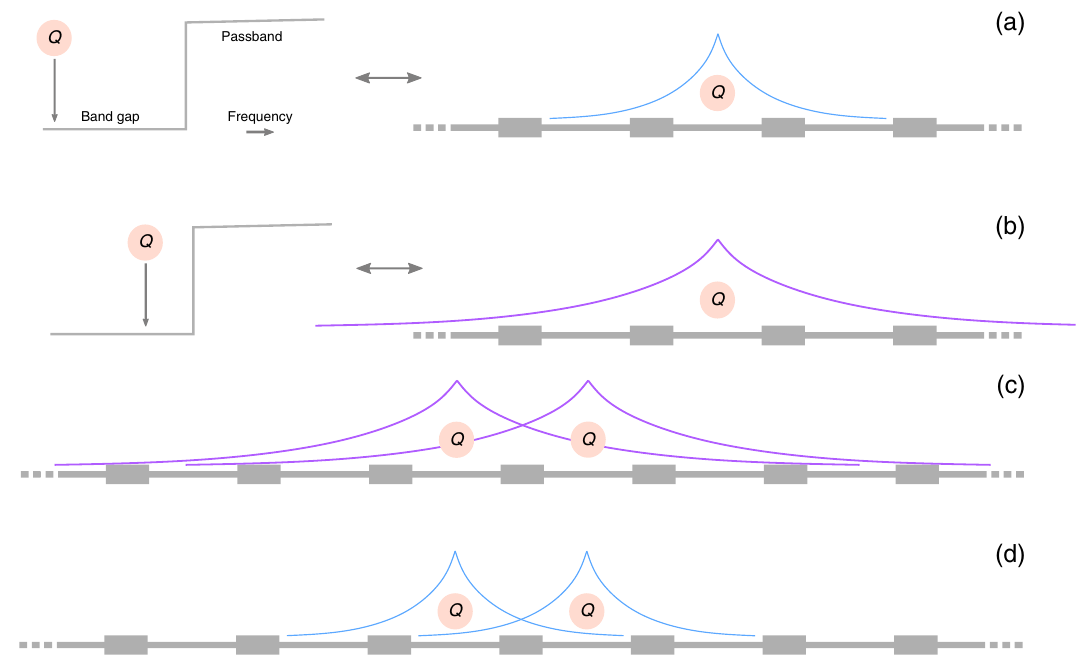
FIG. 7. Visualizing bound states . — A qubit (pink circle) is coupled to one site of a 1D photonic crystal (gray line of alternating width). Coupling a qubit and band edge produces a photonic envelope (blue and purple) that is spatially centered at the qubit location. (a),(b) The localization of the photonic component is determined by the detuning of the qubit from the band edge. (a) is more localized than (b) as the detuning is larger in the former. The overlap of the photonic wave function with the ends of the crystal (not shown) determines the linewidth of the bound state measured in transmission. The strength of the interaction between the bound states, when qubits are resonant with one another, can be understood in (c) and (d) as depending on the localization of the bound